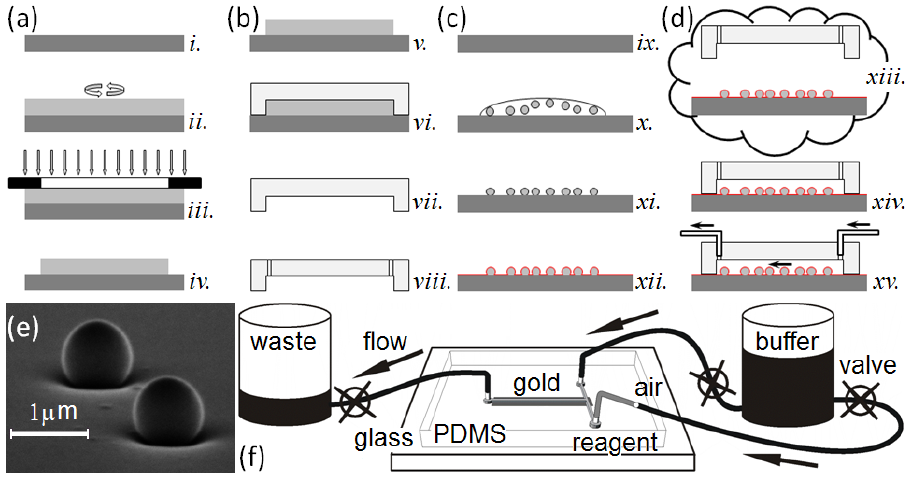
Figure 1. Main steps in microsensor chip fabrication. ( a ) Microfluidic master mold preparation: i. cleaning the glass substrate for the microfluidic mold blank; ii. spin-coating the blank with photoresist and prebaking; iii. exposing the photoresist through a mask to UV light and postbaking; iv. removing any unexposed photoresist from the blank with SU-8 developer and drying. ( b ) Microfluidic housing preparation: v. cleaning the microfluidic mold under N ; vi. casting the microchannels in the housing in PDMS; vii. removing the 2 PDMS housing from the mold; viii. cutting access holes in the microfluidic housing to allow connections to external fluid sources. ( c ) Microsensor substrate preparation: ix. cleaning the cover-glass; x. dispensing the nanosphere solution onto the coverglass; xi. d rying the coverglass under low vacuum to attach the nanospheres to the coverglass; xii. sputtering gold over the nanospheres and glass surface to make a microsensor substrate. ( d ) Microsensor chip preparation: xiii. plasma cleaning the PDMS housing and microsensor substrate;